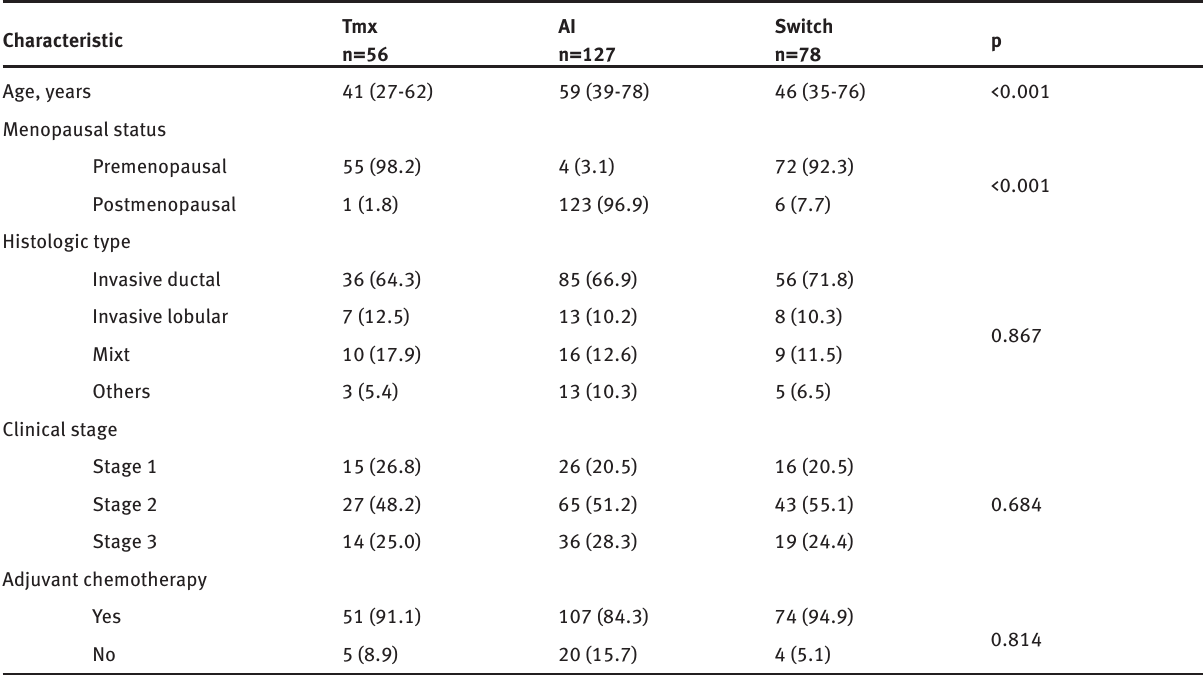
Table 2: Characteristics of the patients in the hormone therapy groups